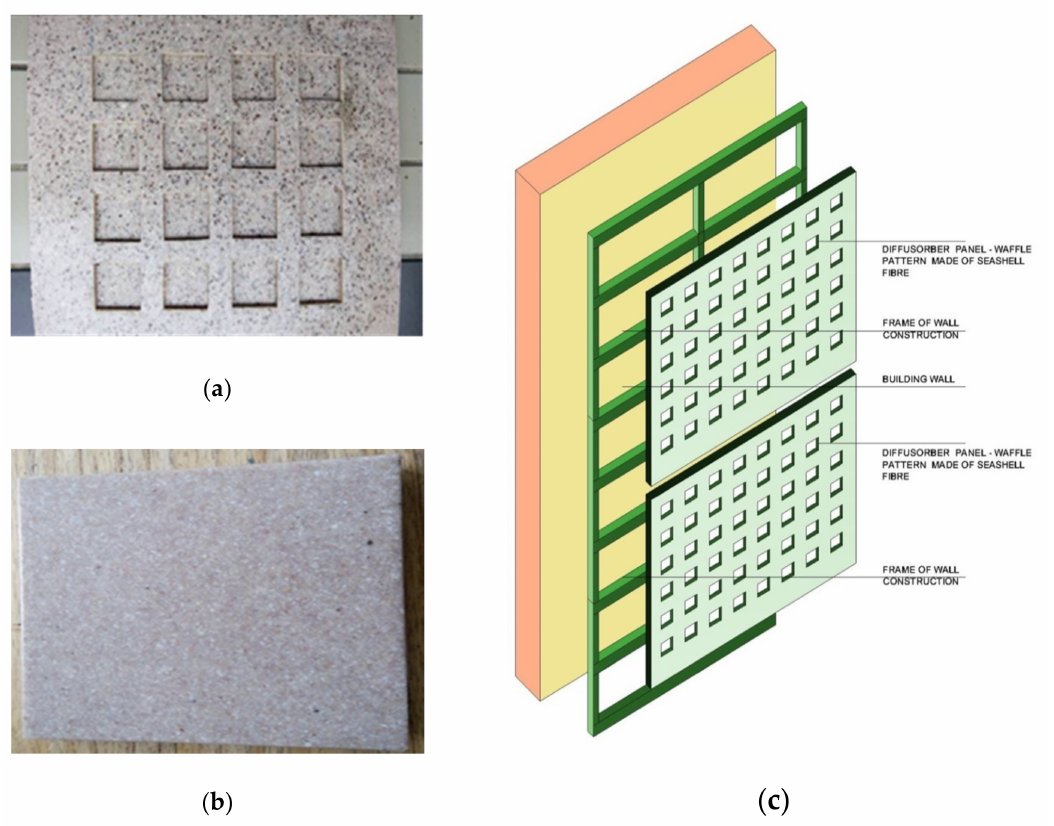
Figure 13. ( a ) Acoustic material with waffle pattern of seashell for interior wall panel; ( b ) another variant of acoustic material with a plain surface texture; ( c ) the application detail of waffle patterned diffuser-absorber in